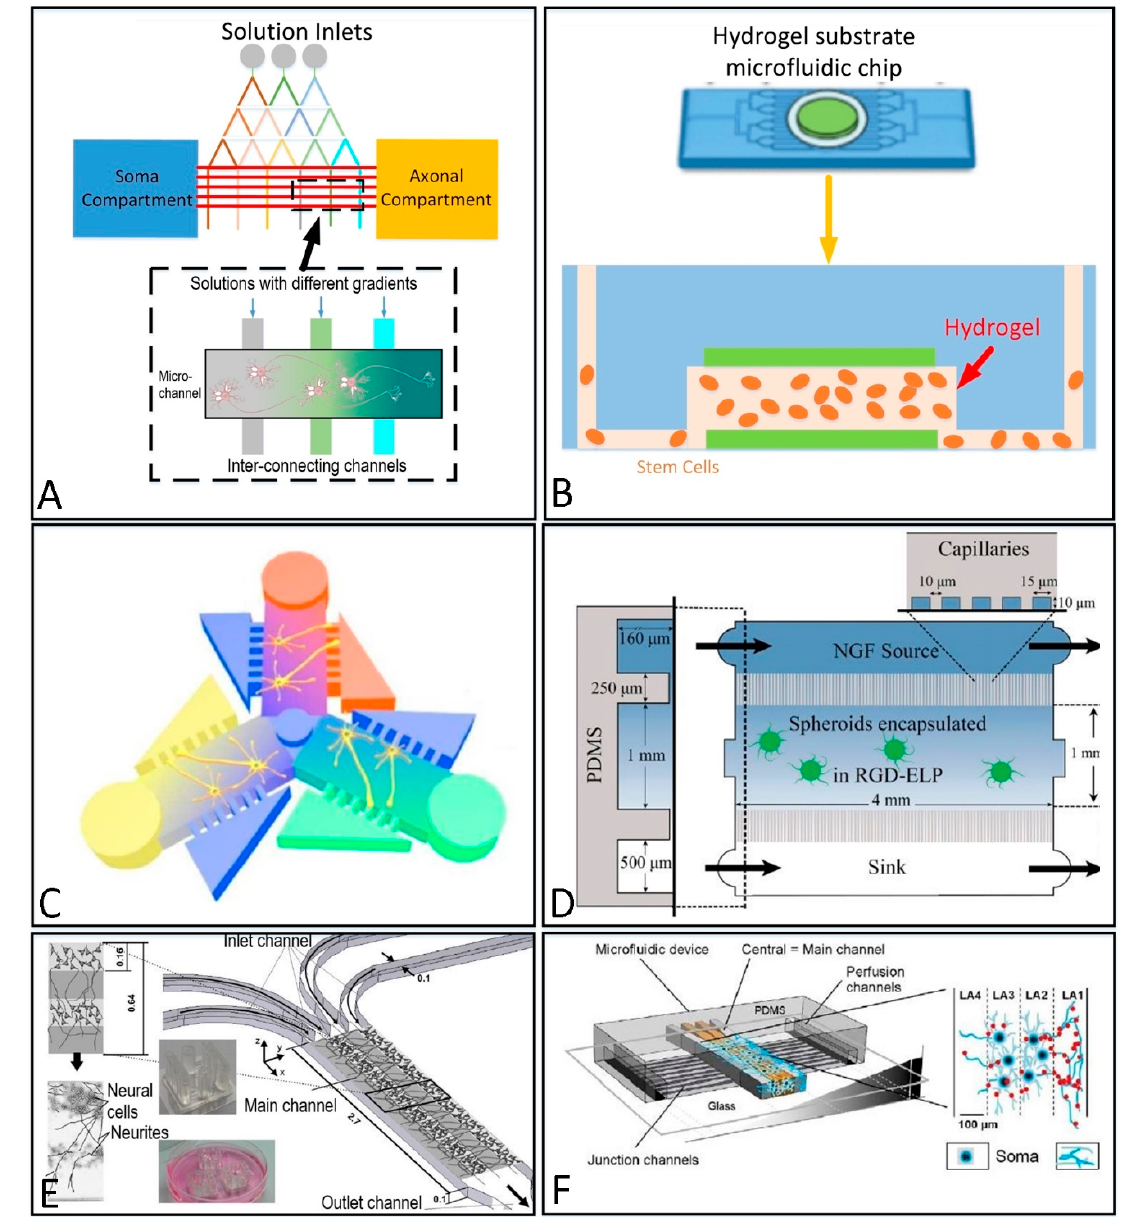
Figure 3. Illustrations of 3D culture structures. ( A ) A typical structure of chemical gradients-based 3D culture microfluidic device. ( B ) Illustration of 3D scaffolds culture microfluidic device using hydrogels. ( C ) The 3D microfluidic device composed of three interconnecting but independent controlled gradient units microgrooves by Y. Tang. ( D ) Microfluidic device that generate NGF gradient through a 3D hydrogel by Romano, N. H. ( E ) The layered structure of the 3D neural cell culture microfluidic device by Kunze, A. ( F ) Microfluidic device combined with micropatterning and gradient generation by Kunze, A. and Valero, A.